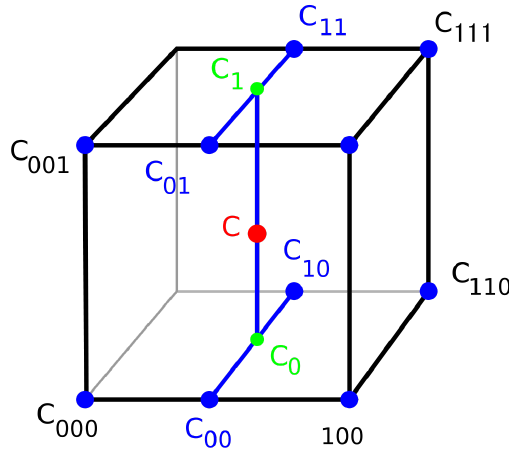
Figure 8. Trilinear interpolation